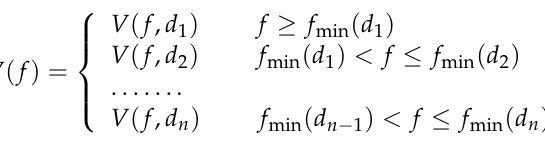
Figure 4. Principle of maximum reliable low-frequency calculation.